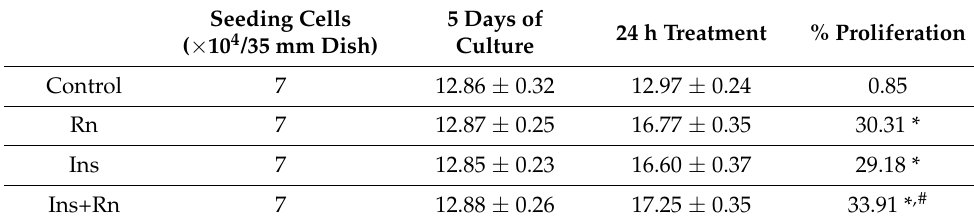
Table 1. Effect of Ins and Rn on astrocytes’ proliferation. Cell proliferation and counting living cells. Astrocytes were isolated and seeded at 7 × 10 4 cells/35 mm dish for 5 days. Cells were incubated without Ins or Rn (control, C), with Rn (10 − 6 M), with Ins (10 − 8 M), or with Ins + Rn (10 − 8 + 10 − 6 M) for 24 h. Trypan blue exclusion was used to count the living cells and monitor cell proliferation. Data are mean ± SD of four independent experiments (four different rats). * p < 0.05 vs. control. # p < 0.05 vs. Ins.